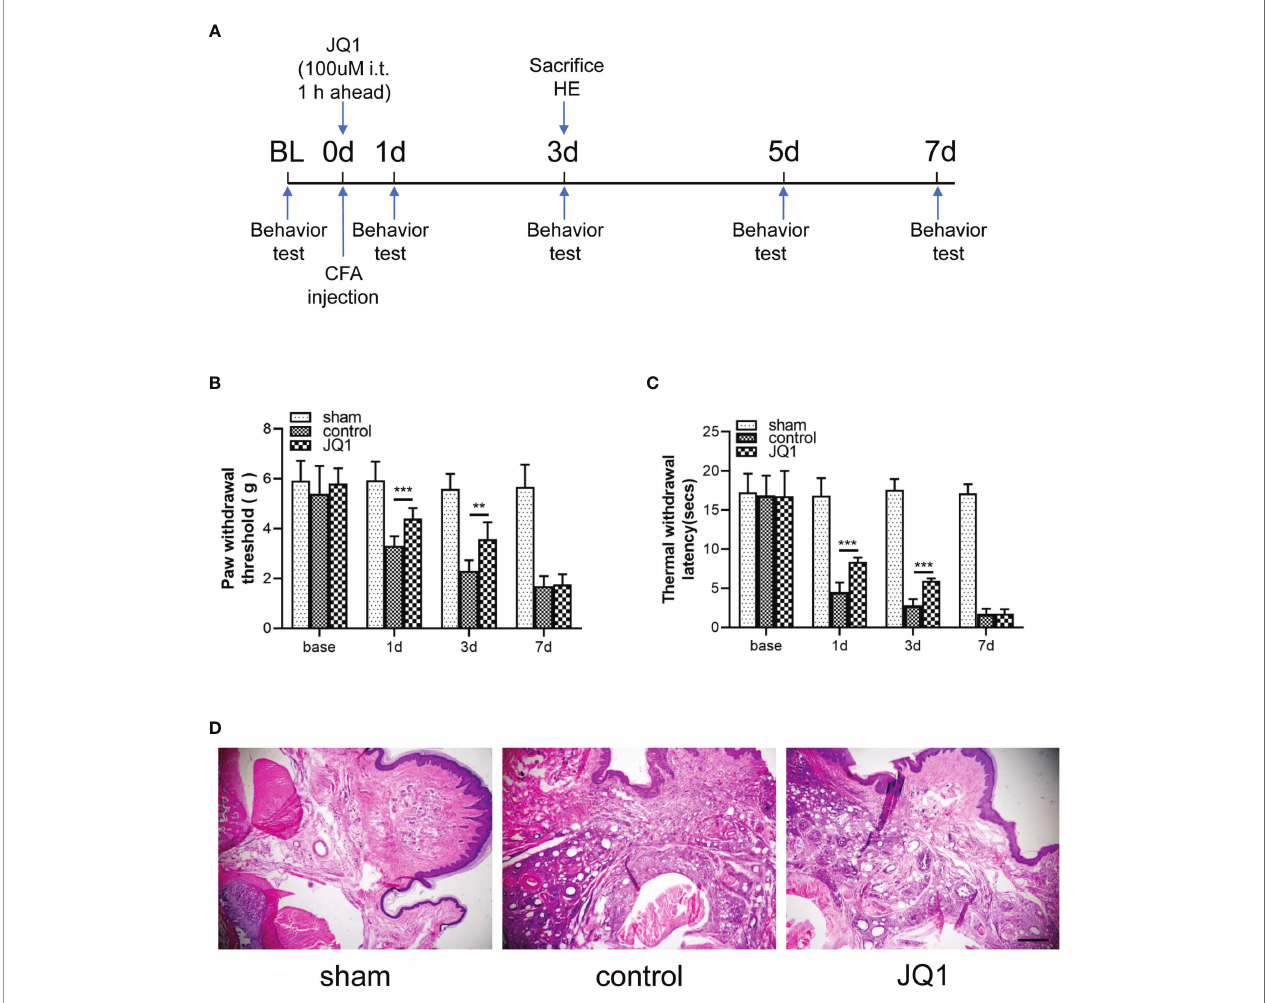
FIGURE 2 | CFA-induced in fl ammatory pain and paw in fl ammation was attenuated by JQ1, the BRD4 inhibitor. (A) Experimental design to test the antinociceptive effects of BRD4 inhibitor JQ1 in the CFA-induced in fl ammatory pain model. (B, C) Effects of BRD4 inhibitor JQ1 on thresholds of mechanical allodynia (B) and thermal hyperalgesia (C) . Tests were carried out before CFA injection and on days 1, 3,and 7, n=6 mice/group. (D) In fl ammation in mouse paw tissues by H&E staining, n=3 mice/group, all fi gures were magni fi ed by 400×. Data were presented as mean ± standard deviation (SD). (**P < 0.01, ***P <